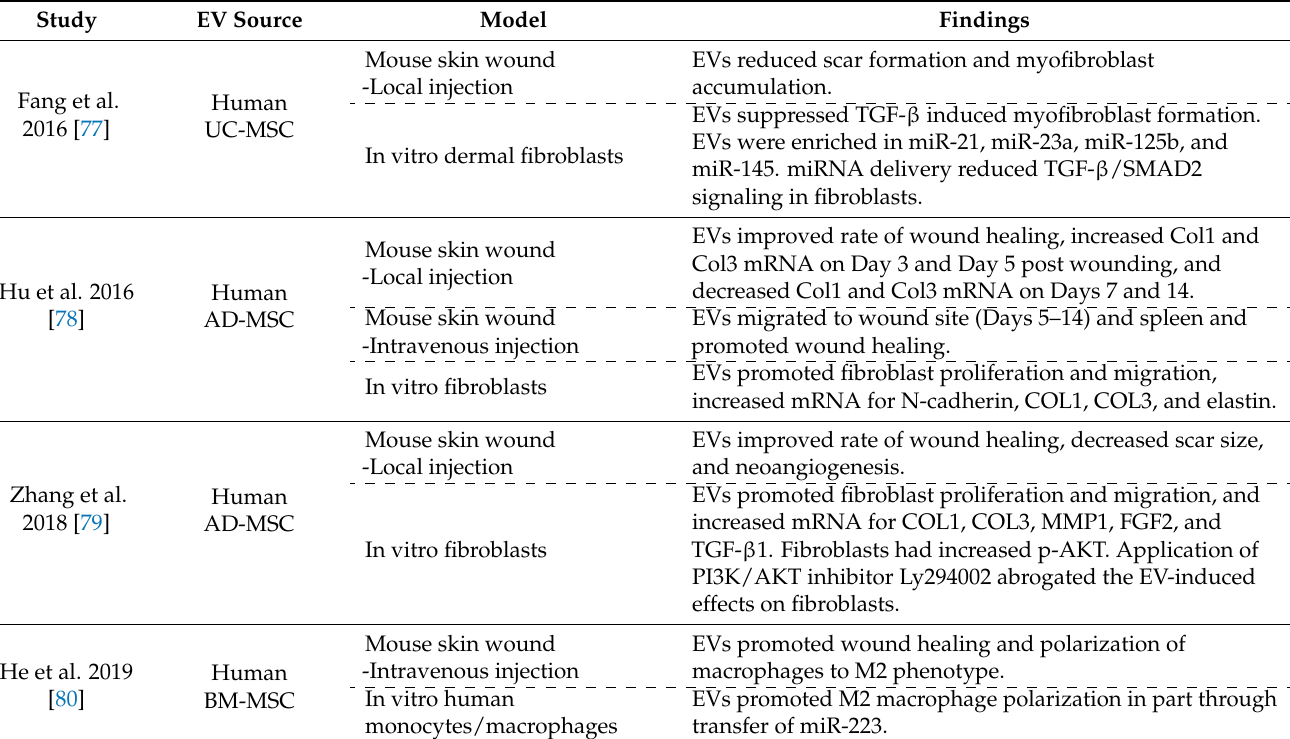
Table 1. Studies that evaluated an in vivo role for MSC-EVs in wound